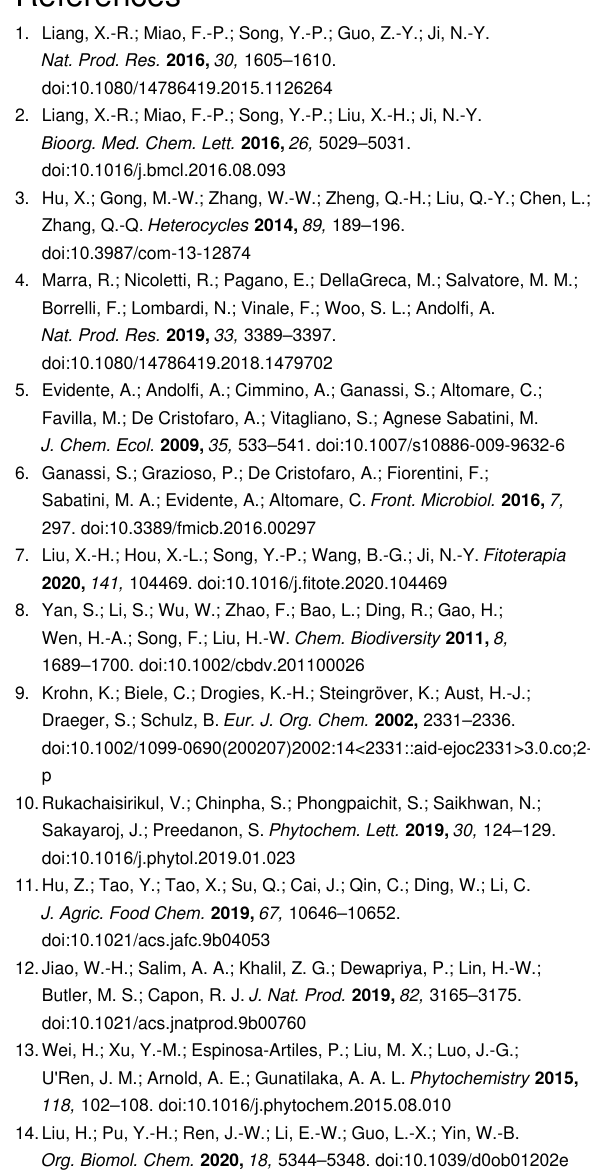
Table 1; HRMS–ESI ( m / z ): [M + Na] + calcd for C 15 H 22 O 5 Na, 305.1356; found, 305.1359.